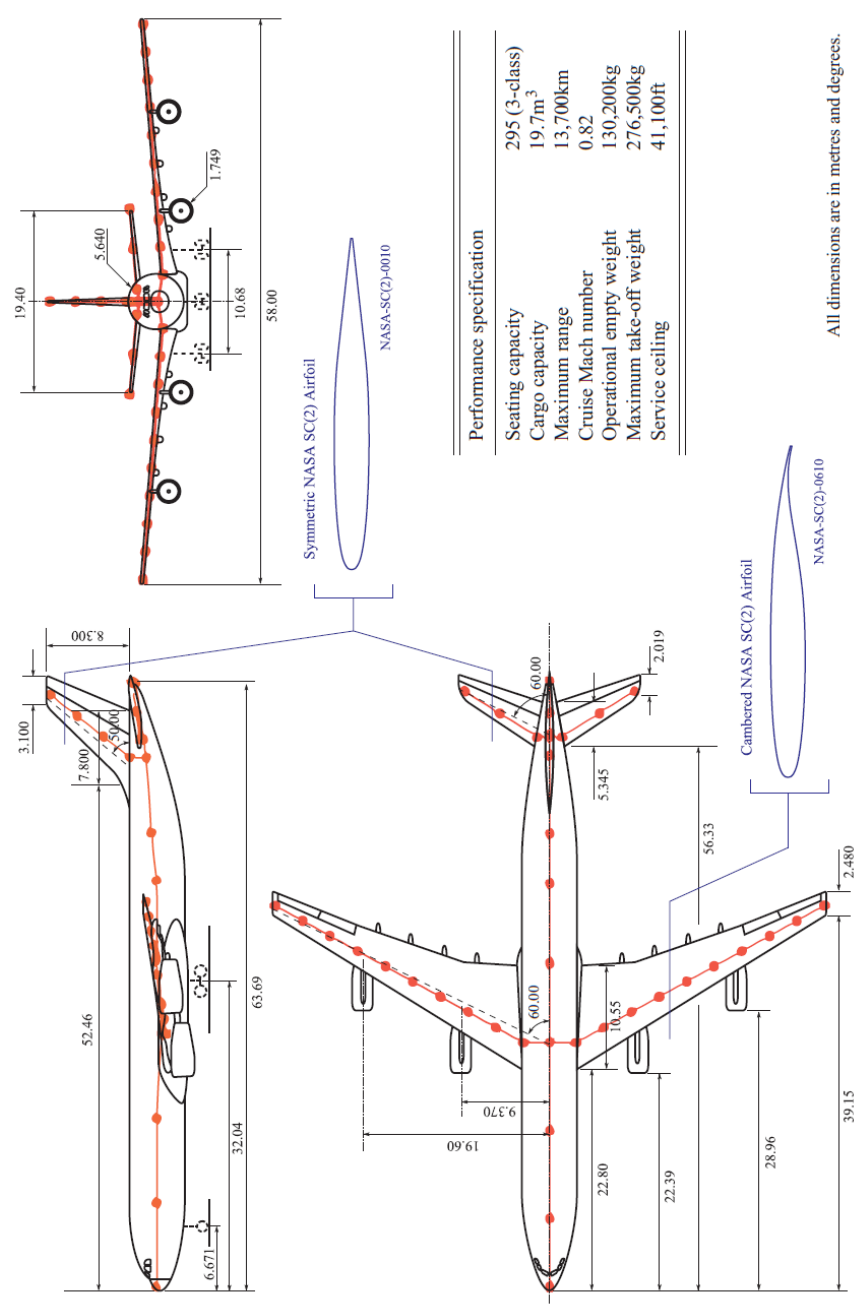
Figure A2. Cranfield University Airbus AX-1 model: geometry, performance and beam-element representation